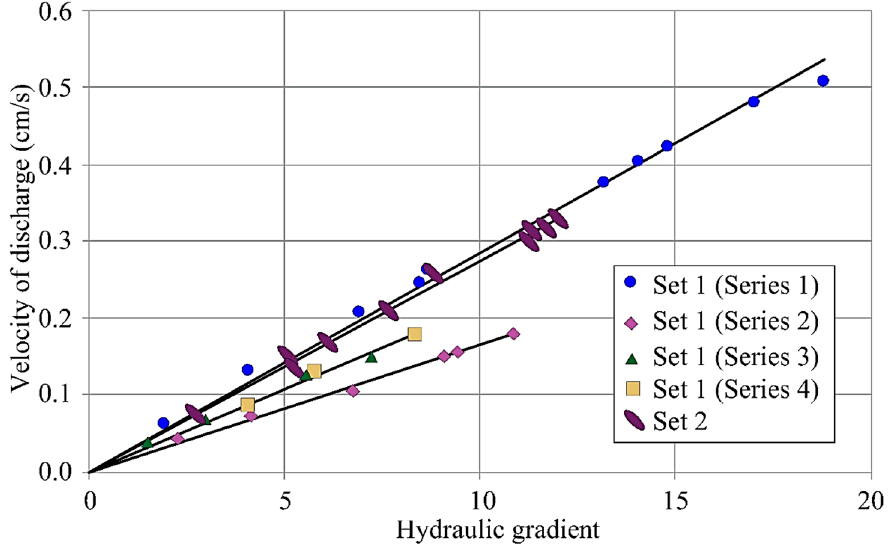
Figure 13. Darcy’s novel finding of a linear relationship between the velocity of flow and hydraulic gradient [89,90].